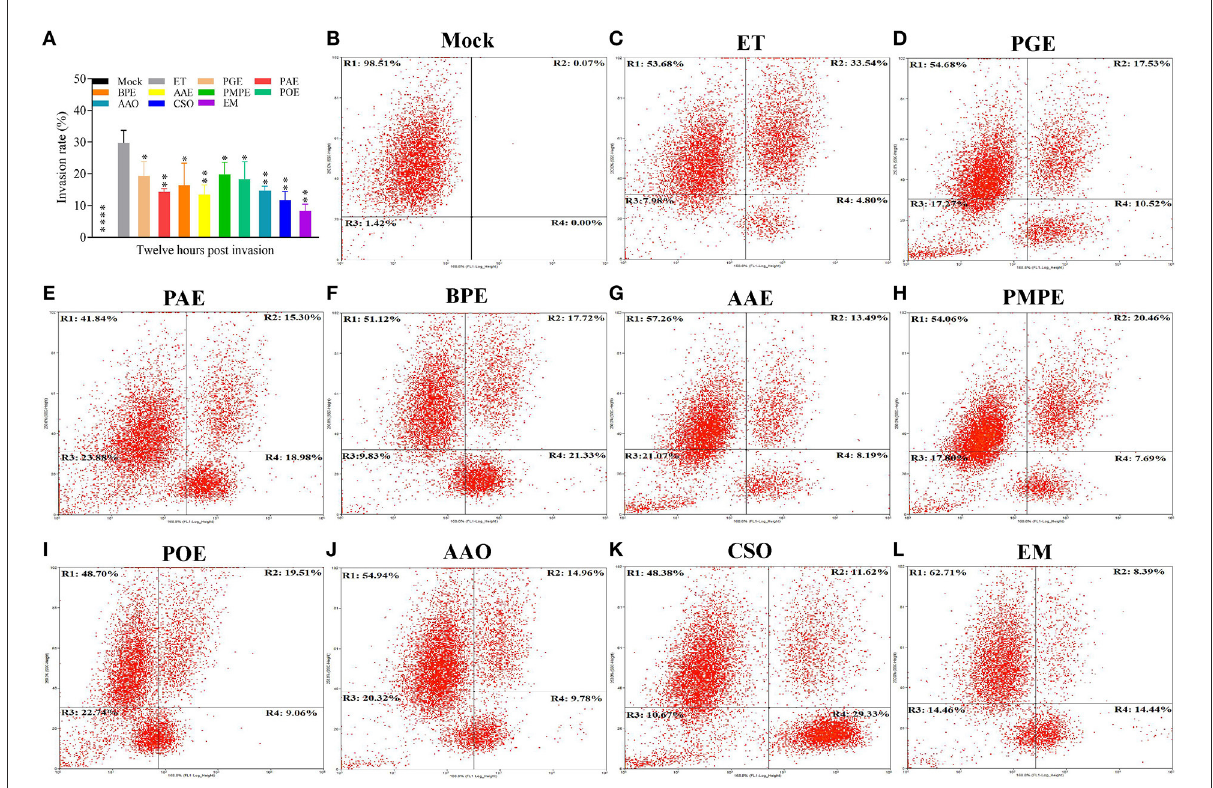
FIGURE3 Invasion inhibition of the eight plant extracts and essential oils and the EM in vitro . Flow cytometry was performed 12h after sporozoites were cultured with the individual extracts and essential oils, EM, or mock in DMEM. (A) Invasion rate (%) of the ET and samples administered to one of the eight plant extracts and essential oils or the EM. Results represent three independent experiments. * P < 0.05, ** P < 0.01, **** P < 0.001 (each group compared with the ET group). Representative plots of the (B) mock, (C) ET, (D) PGE, (E) PAE, (F) BPE, (G) AAE, (H) PMPE, (I) POE, (J) AAO, (K) CSO, and (L) EM control groups. R1, ETS uninfected cells; R2, ETS-infected cells; R3, cell fragments; R4, ETS of uninfected cells. AAE, Acalypha australis L. extract; AAO, Artemisia argyi Levl. et Vant. essential oil; BPE, Bidens pilosa L. extract; CSO, Camellia sinensis (L.) O. Ktze essential oil; EM, extract and essential oil mixture (non-toxic concentrations of PGE, PAE, BPE, AAE, PMPE, POE, AAO, and CSO); ET, Eimeria tenella ; ETS, ET sporozoites; PAE, Plantago asiatica L. extract; PGE, Punica granatum L. extract; PMPE, Pteris multifida Poir extract; POE, Portulaca oleracea L. sp. Pl.